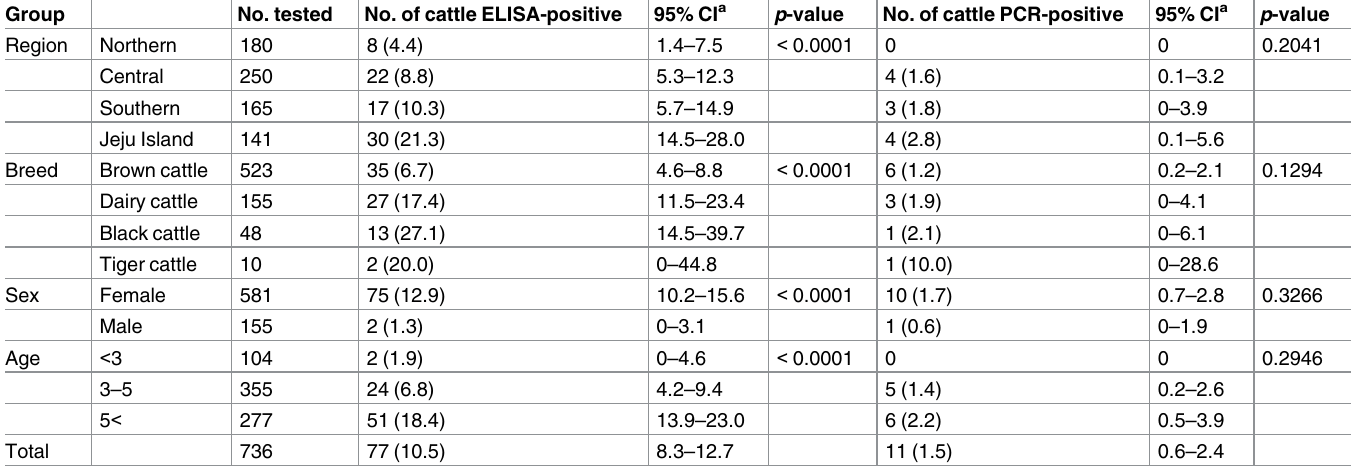
Table 1. Prevalence of Coxiella burnetii in 736 cattle at national breeding stock farms in South Korea during 2014.